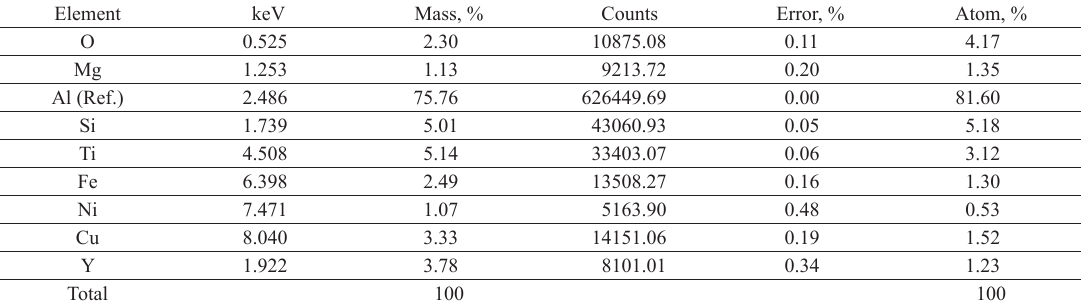
Figure 3. Bright-field electron microscopic image of structure of surface layer of modified Al-11wt%Si alloy (a); c-e – images of the given layer formed in the characteristic X-ray radiation of silicon atoms (c), yttrium (d) and titanium (e); the image (b) is formed by superimposing of images (c-e) on (a). Table 2. Chemical composition of Al-11wt%Si alloy subjected to complex treatment combining the electroexplosion alloying and the subsequent irradiation by pulsed electron beam.